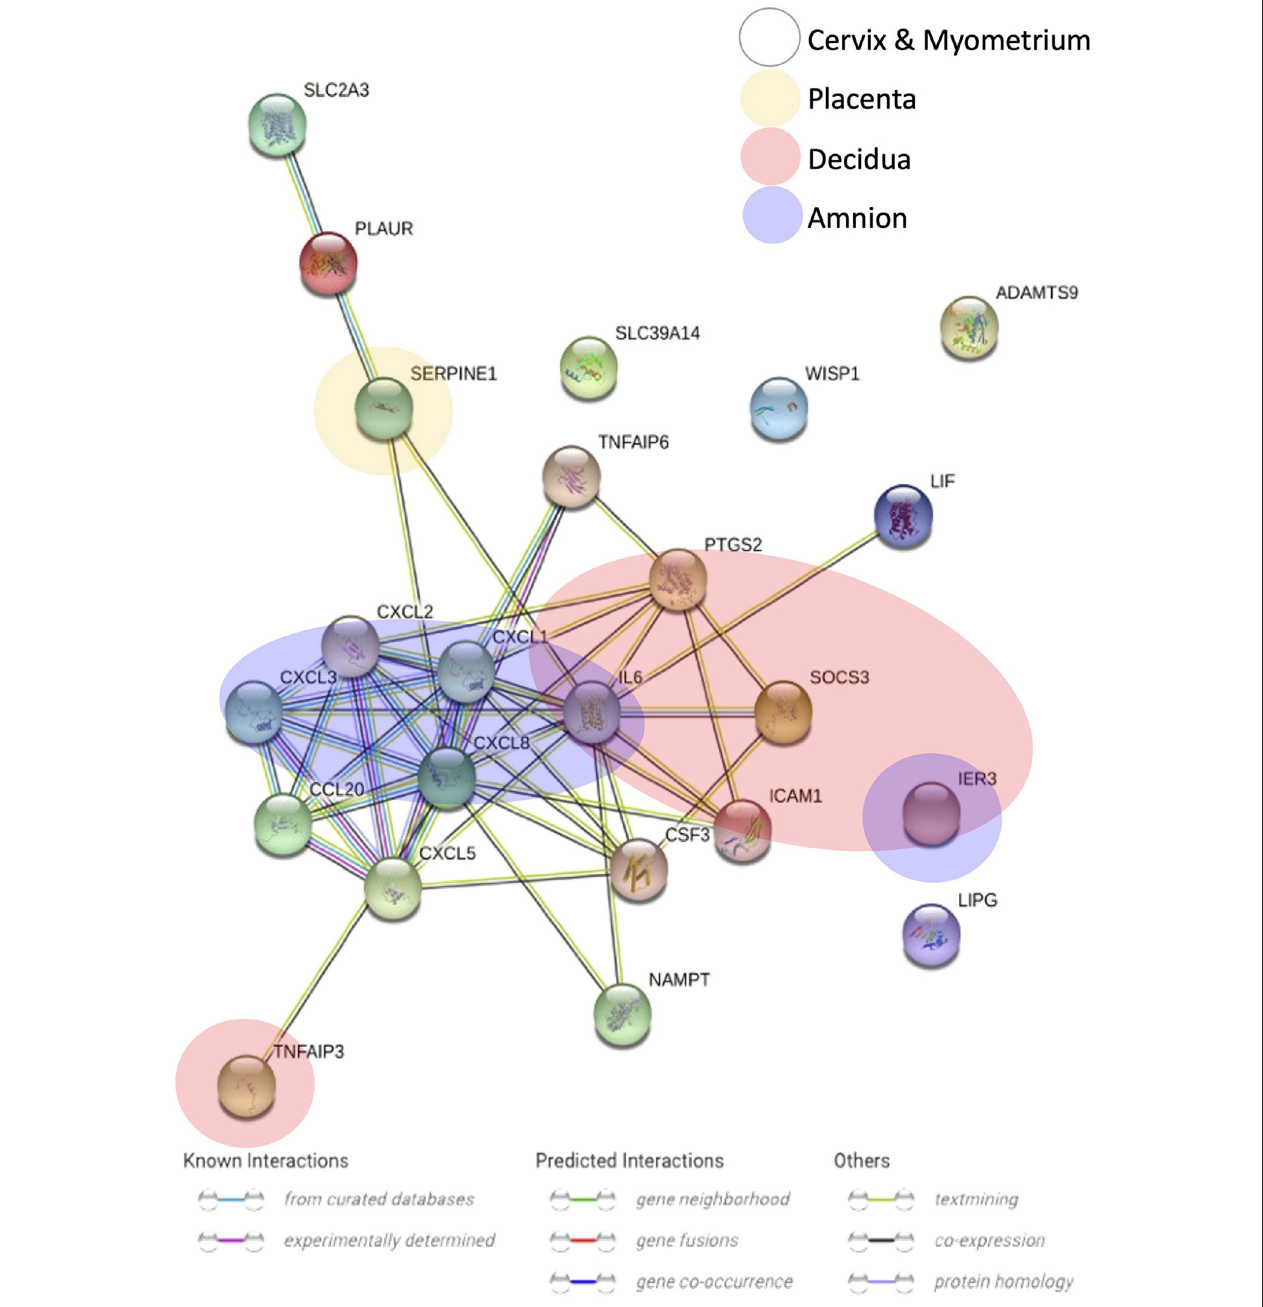
FIGURE 5 | Gene-gene interaction analysis of the differentially expressed genes that overlapped across gestational tissues. Nodes represent genes, edges represent gene-gene association, and colors of edges stand for association evidence in the STRING database.